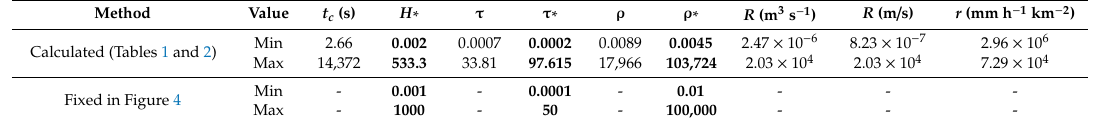
Table 3. Minimum (Min) and maximum (Max) values of derived parameters used in the suggested procedure and runo ff results. Bold values refer to H ∗ and τ ∗ input parameters, and to ρ ∗ output parameter, considered in Equations